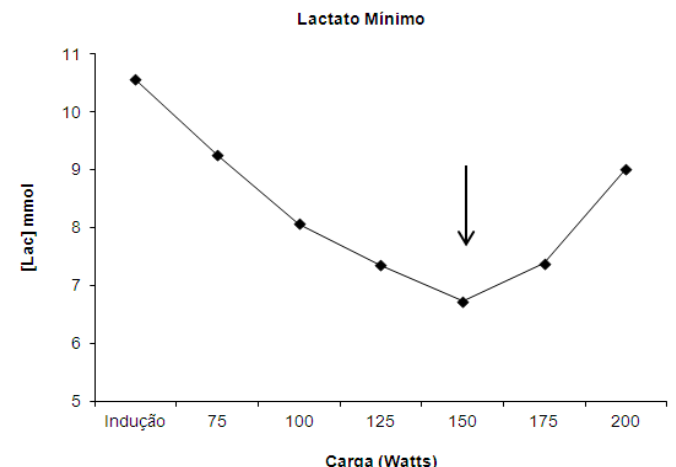
Figura 1: Exemplo de determinação do protocolo de lactato mínimo (LM) em um indivíduo. Indução a hiperlactatemia, mais parte incremental, observando-se a intensidade de LM de modo visual em 150 watts e potência máxima em 200 watts